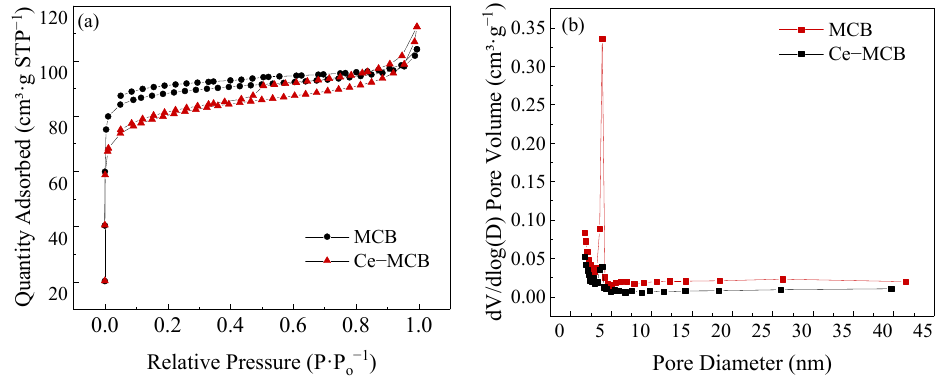
Figure 2. The N 2 adsorption-desorption curves ( a ) and pore size distribution ( b ) of MCB and Table 1. Pore structural parameters of biochar.